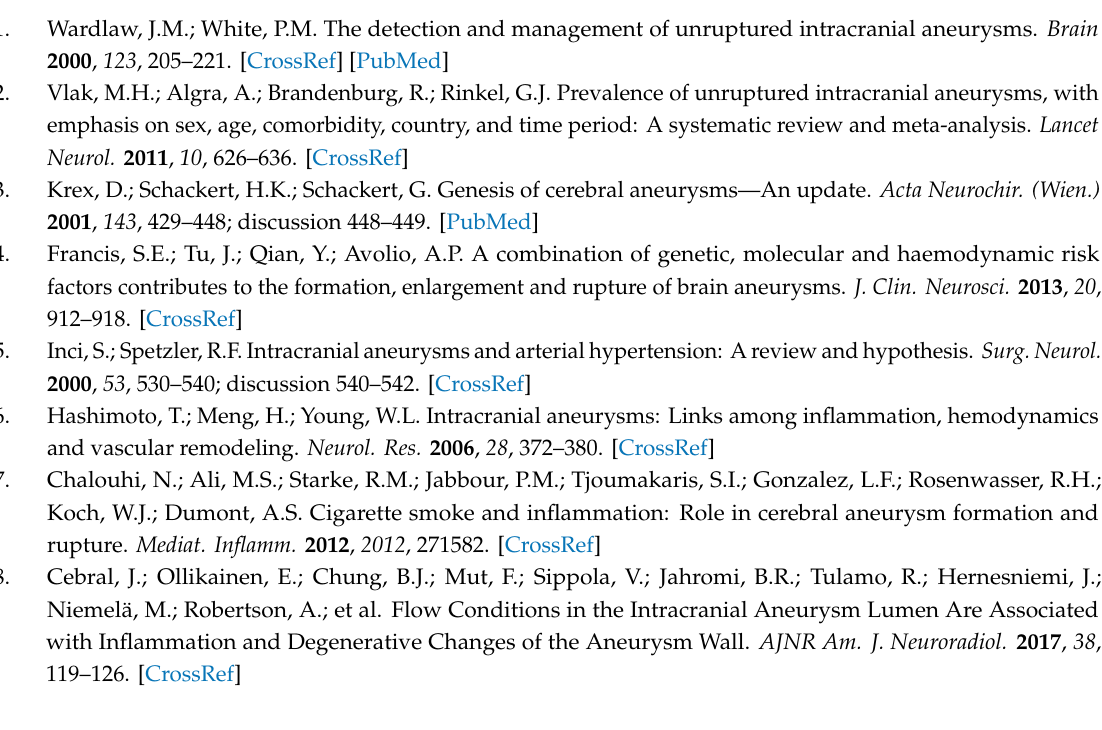
Table S1. IL-8 and MCP-1 cerebrospinal fluid (CSF) and serum concentrations and their Quotients in unruptured intracranial aneurysm (UIA) patients compared to control group. Table S2. CSF and serum IL-8 and MCP-1 concentrations and Quotient values depending on aneurysm risk factors: median age value, gender, smoking, hypertension and